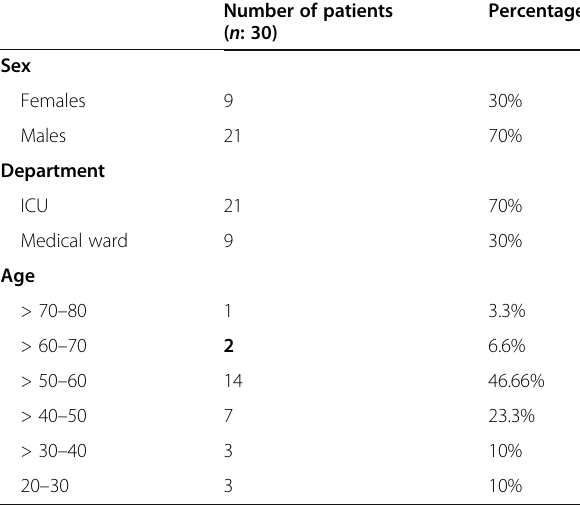
Table 1 Distribution of the studied patients according to age, sex, and department of isolation Number of patients ( n :